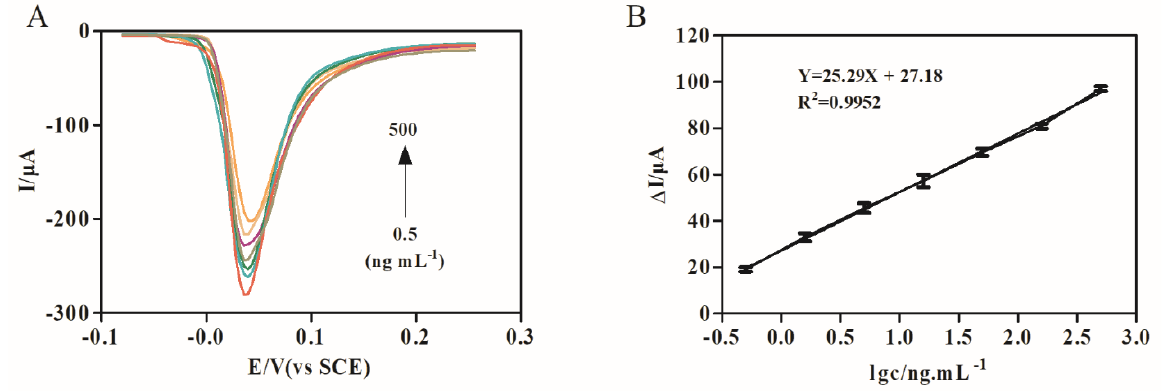
Figure 6. ( A ) DPV responses of the electrochemical immunosensor incubated with various concentra- tions of ASA (0.50, 1.60, 5, 16, 50, 160, 500 ng mL − 1 ), and ( B ) The logarithmic calibration plot for ASA measurements in the range of 0.50–500 ng mL − 1 (error bars: SD, n =